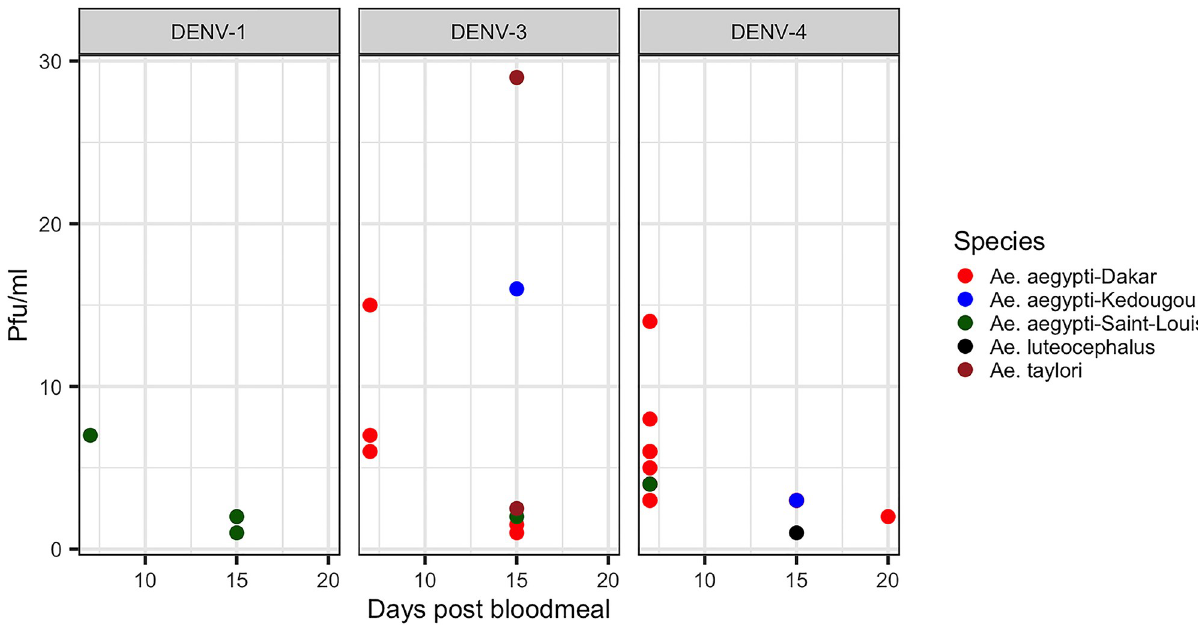
Fig 3. Virus titers of infected mosquito saliva at 7 and 15 dpbm (PFU/ml).